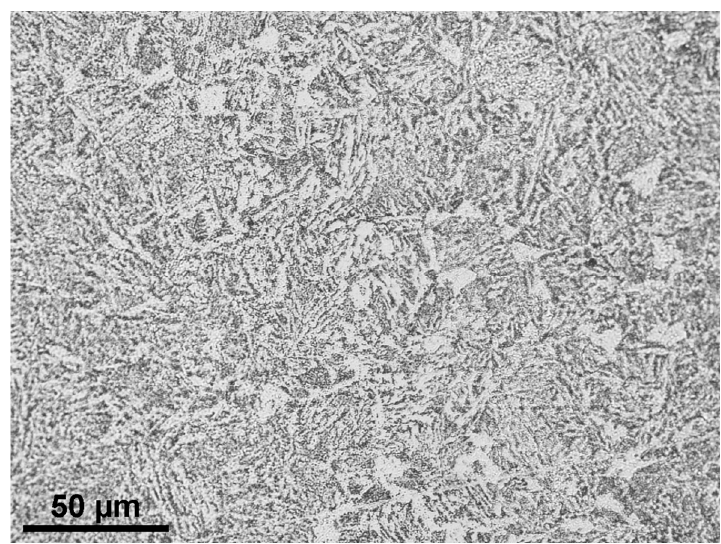
Table 1. Chemical composition of EA4T steel, according to [19].